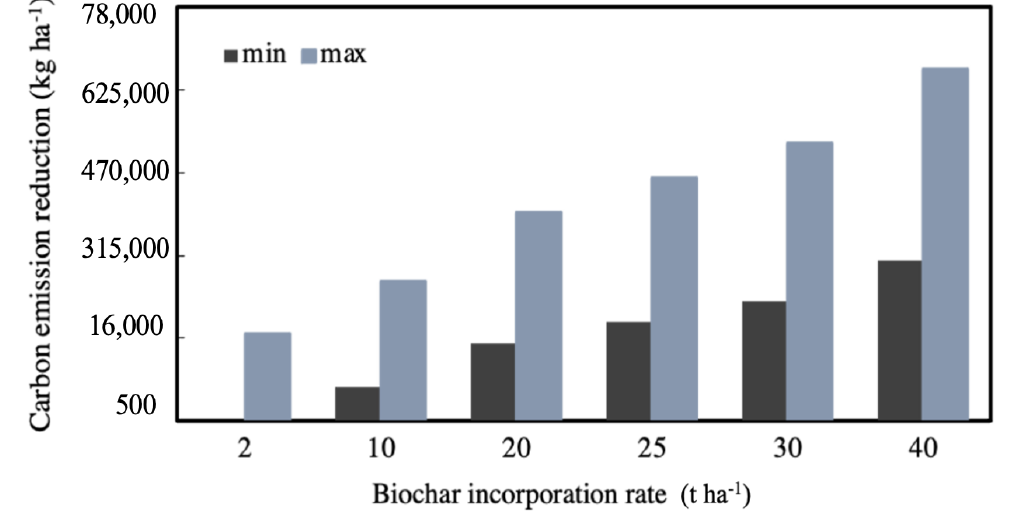
Figure 4. Carbon reduction potentials with biochar amendment in paddy soils.